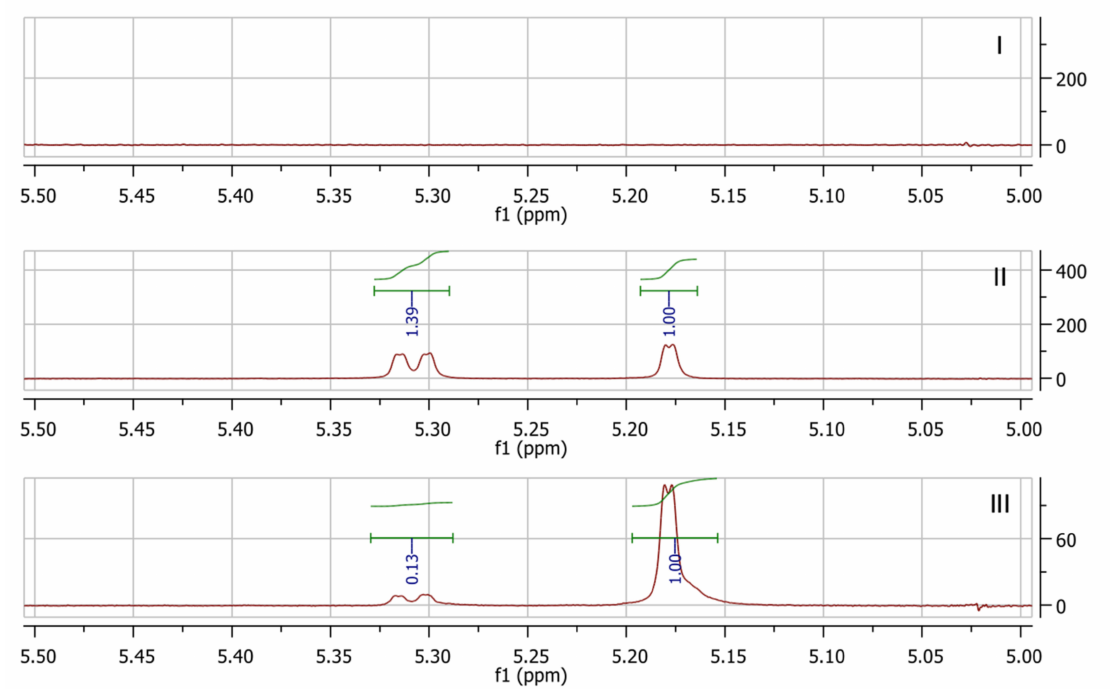
Figure 3. 1 H-NMR spectra of unreacted polymer and crosslinker ( I ) after 2 h ( II ) and 48 h ( III ) at 65 ◦ C (only the endo/exo protons are shown).